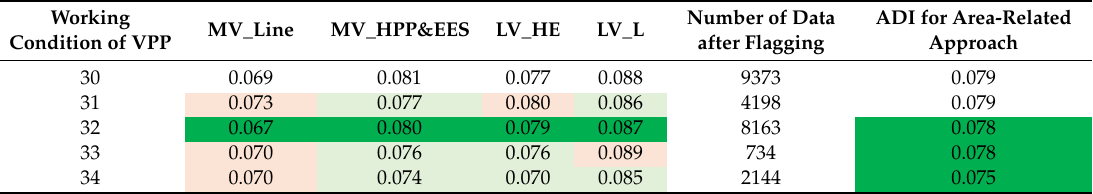
Table 10. Impact of flagging concept for area-related